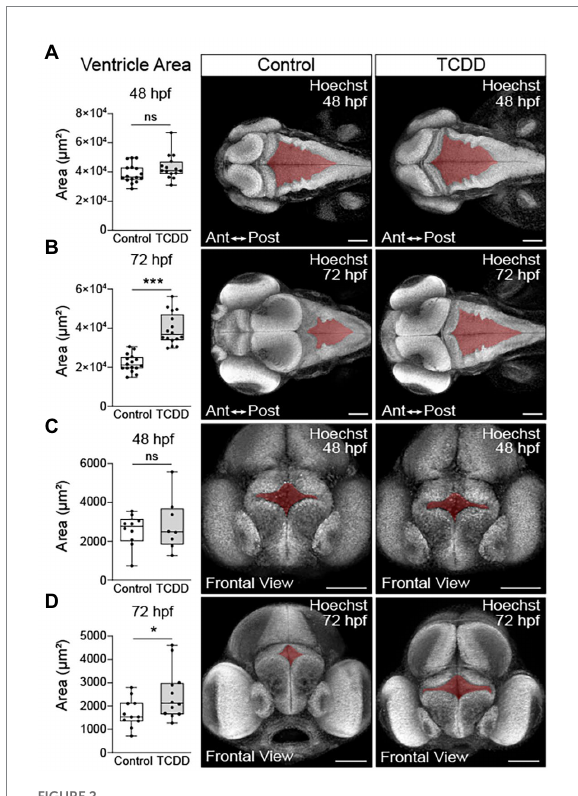
FIGURE 2 TCDD exposure increases brain ventricle size. To determine the impact of TCDD exposure on ventricular development, the hindbrain (A,B) and forebrain (C,D) ventricles were measured in embryos ranging in age from 48 to 52 hpf (A&C) and larvae from 72 to 76 hpf (B,D) . TCDD exposure significantly increased hindbrain and forebrain ventricle size at 72 hpf (B,D) with non- significant trends observed early in development. Dorsal 10x magnification (A,B) and frontal (C,D) 20x confocal micrographs of zebrafish embryos and larvae stained with Hoechst. N = 15–17 fish/group hindbrain across 3 replicates; n = 8–12 fish/group forebrain across replicates. Anterior (Ant) is left, posterior (Post) is right in confocal micrographs (A,B) . Scale bar = 100 μ m. Statistical significance determined by Welch’s t -test, * p < 0.05, **** p <